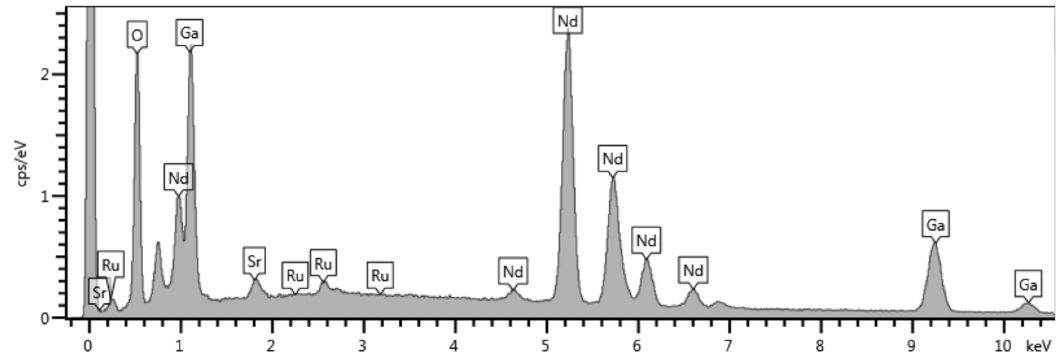
Figure 1. EDS spectrum of SRO film grown on NGO substrate.